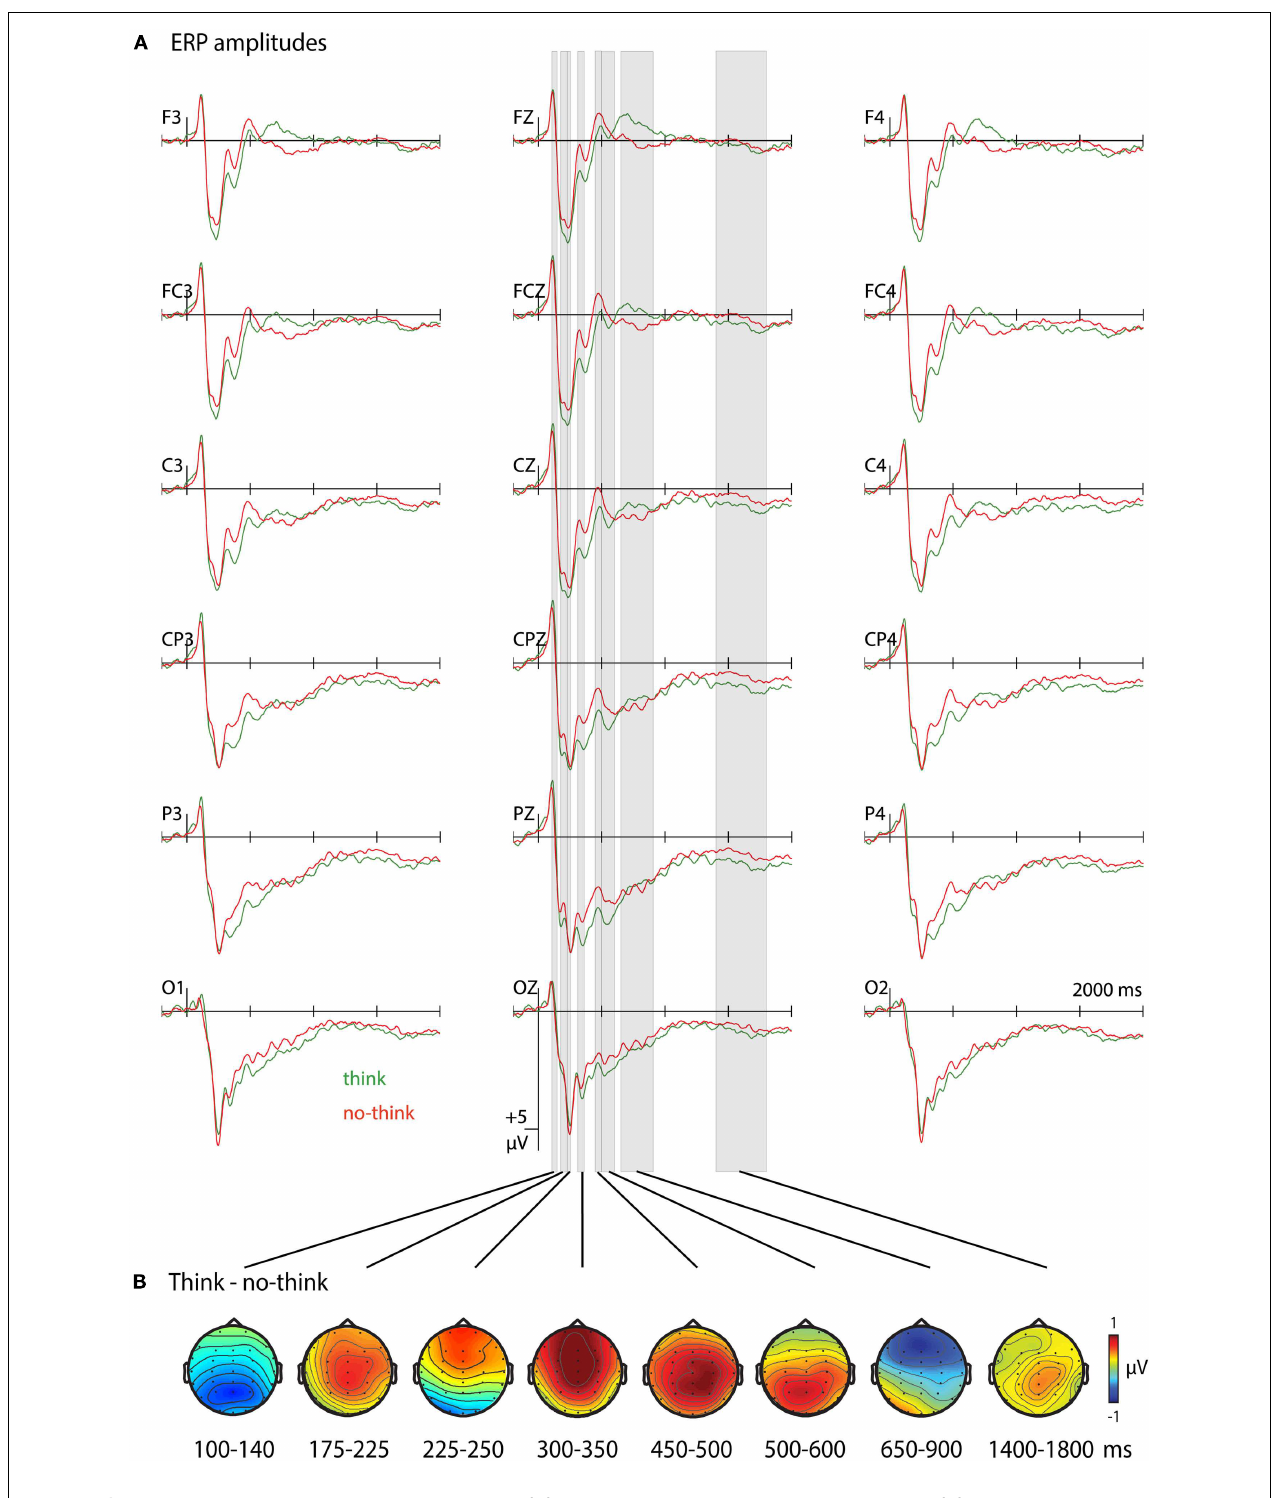
FIGURE 2 | ERP amplitudes during the think/no-think phase. (A) Grand average ERPs to learned items from the think and no-think conditions.The waveforms are shown for the 18 electrode sites used for statistical analyses.